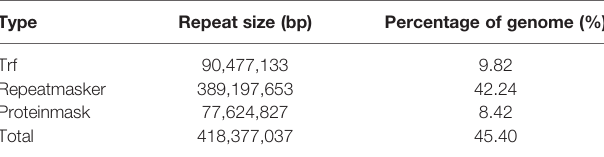
TABLE 3 | Statistics of repetitive sequences in A. ommaturus